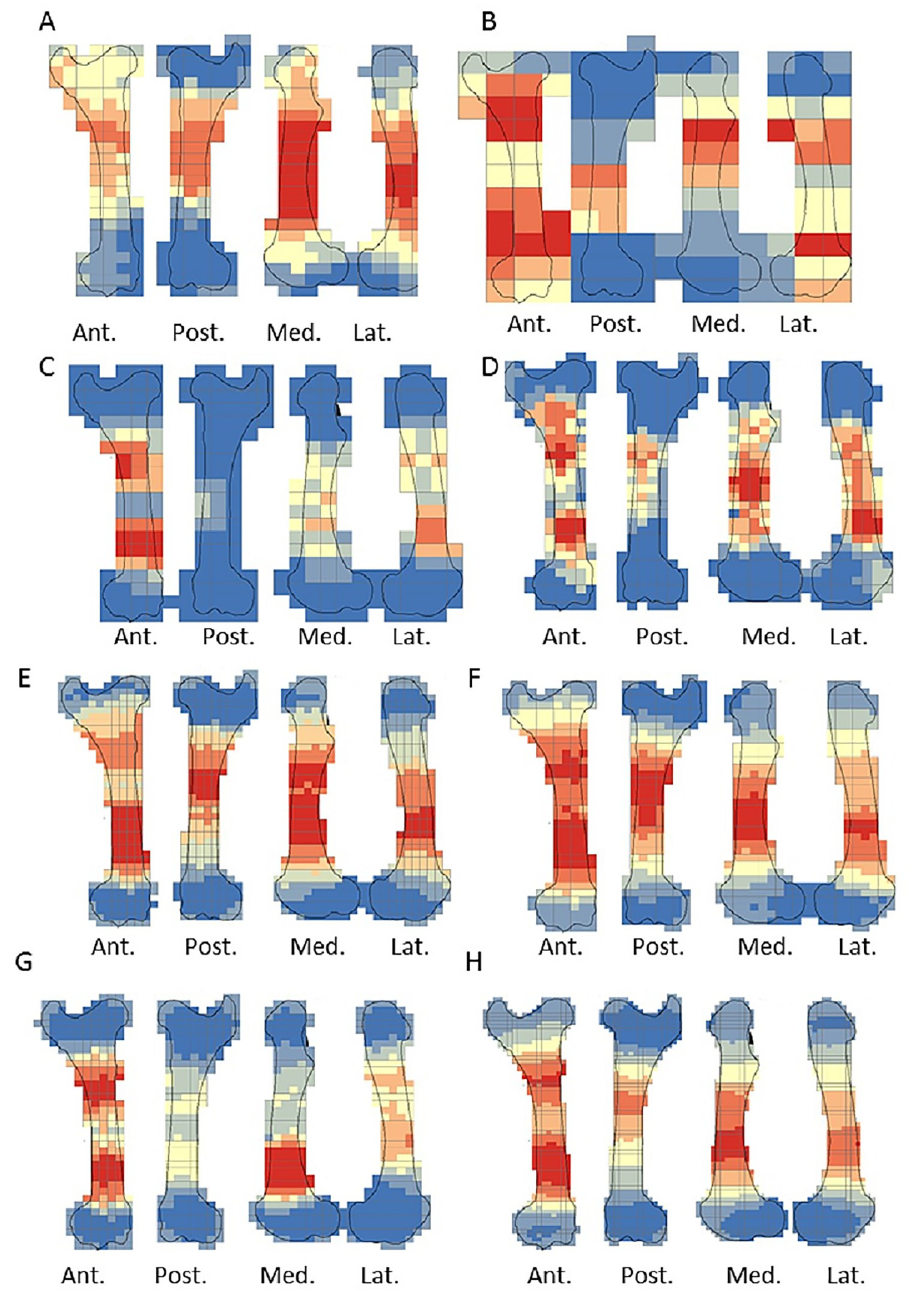
Fig 10. Optimized hot spot analysis of combined percussion marks from the femurs in each series. A-E- Individual n˚3; B-F- Individual n˚5; C-G- Individual n˚8; D-H- Merged femurs series; A, B, C and D: “CNA” Percussion marks and E, F, G and H: pits and grooves (Ind.: